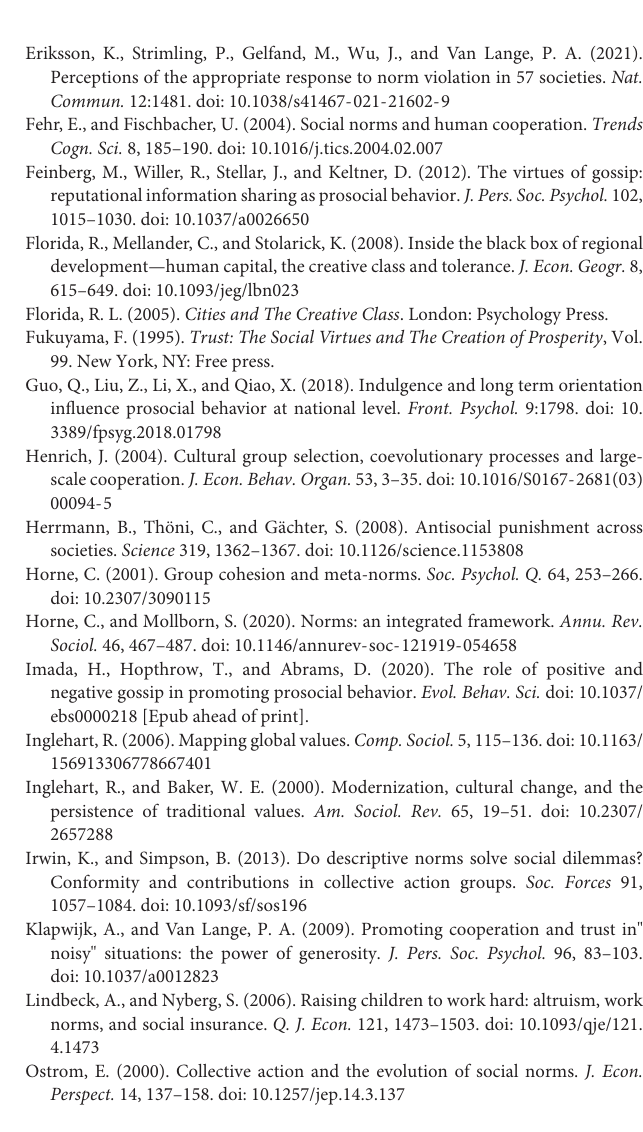
Supplementary Figure 1 | Pearson correlations between cooperative measures and predictors of cooperation. Whether the cooperativeness of societies is measured by behavior, norms, or metanorms, the value of tolerance is consistently the strongest or second strongest among a wide range of predictors. Error bars signify 95% confidence intervals. Note that sample sizes vary across cooperative measures and